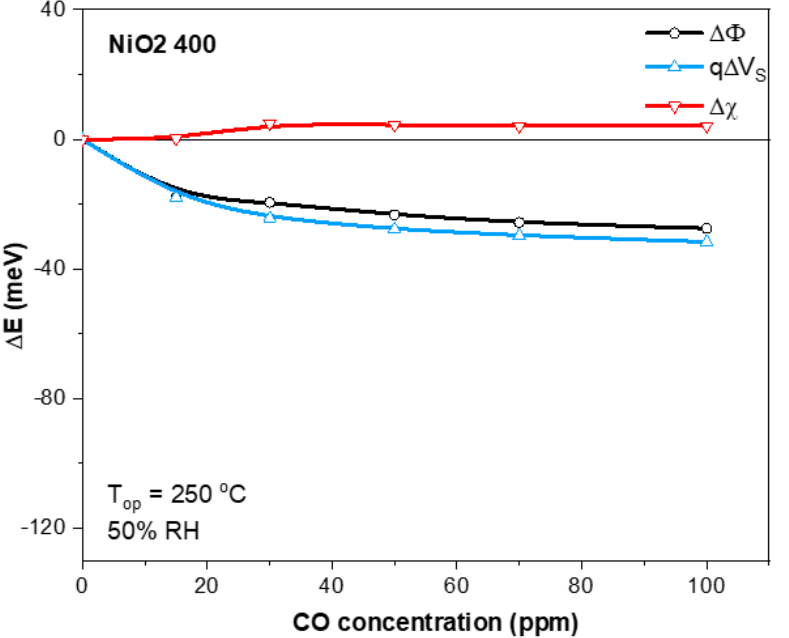
Figure 7. The decoupled energetic contributions with respect to CO concentration for NiO1 400 when operated at 250 °C under 50% RH background atmosphere.